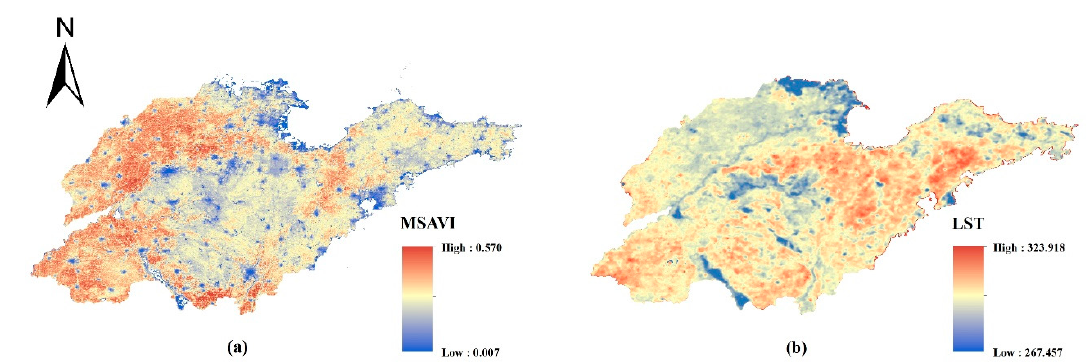
Figure 11. ( a ) A map of the annual average Modified Soil-Adjusted Vegetation Index (MSAVI) for Shandong Province; and ( b ) the distribution map of the annual average land surface temperature (LST) (k) in Shandong Province after reconstruction.